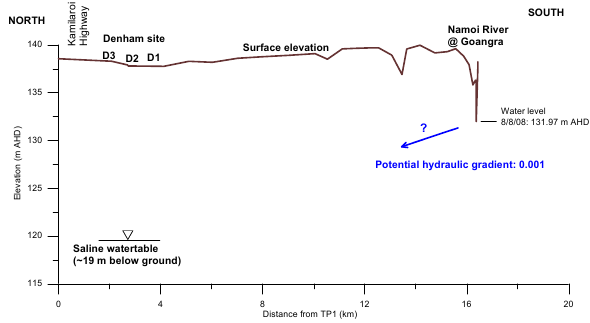
Fig. 7. Elevation transect from north to south through the Denham site to the Namoi River. The relative elevation of the saline water table at Denham, and the river level in January 2008 are